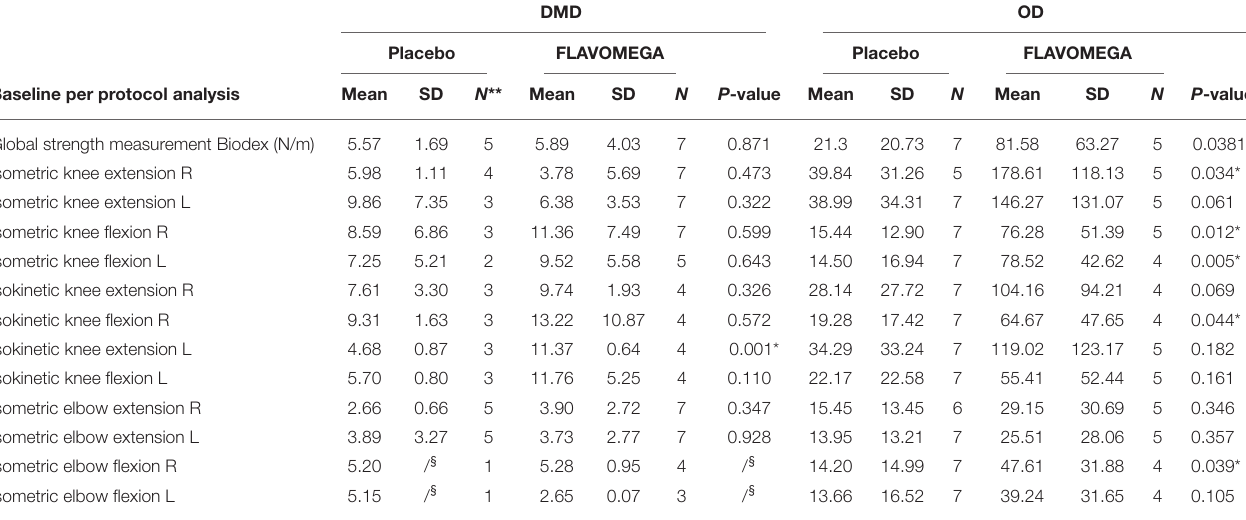
TABLE 6 | Global strength of DMD and OD included patients at baseline and the values concerning the single Biodex